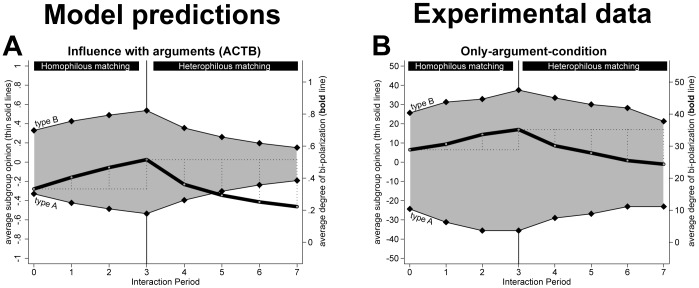
Predictions of ACTB (left panel) and results of the experiment (right panel).